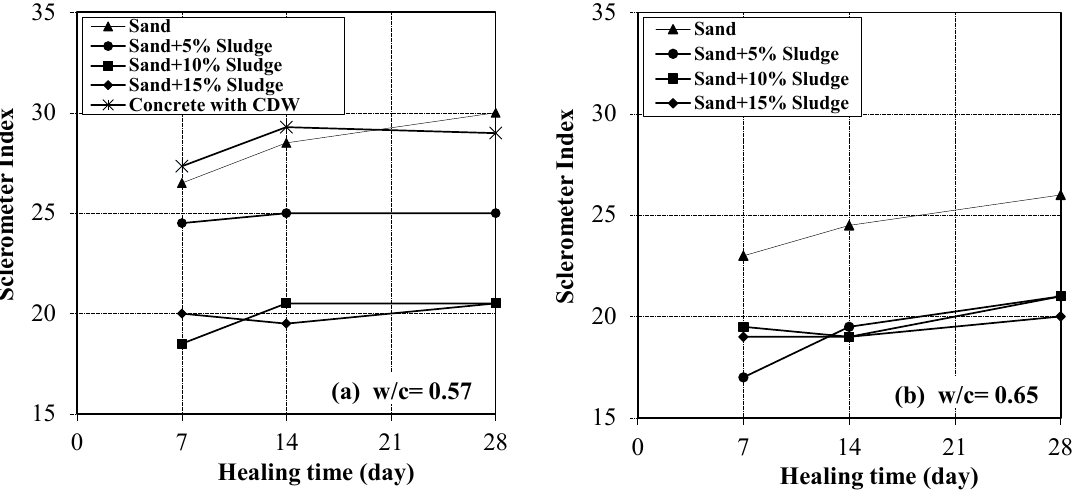
Figure 7. Sclerometer index versus healing time: ( a ) conventional concrete, with sewage sludge and with CDW [27], w/c = 0.57 and ( b ) conventional concrete with sewage sludge, w/c = 0.65.